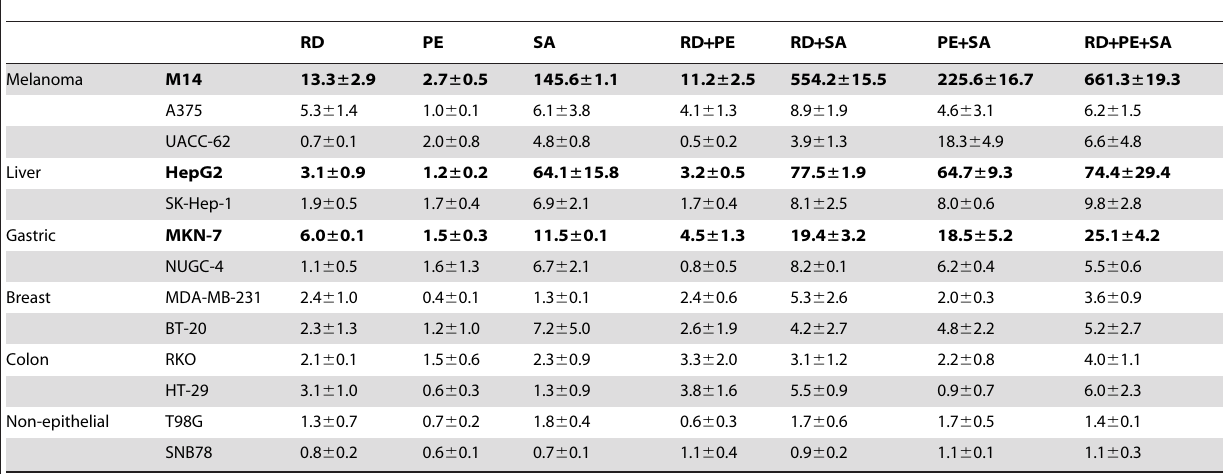
Table 1. NIS mRNA expression in different human cancer cells after drug treatments (mean 6